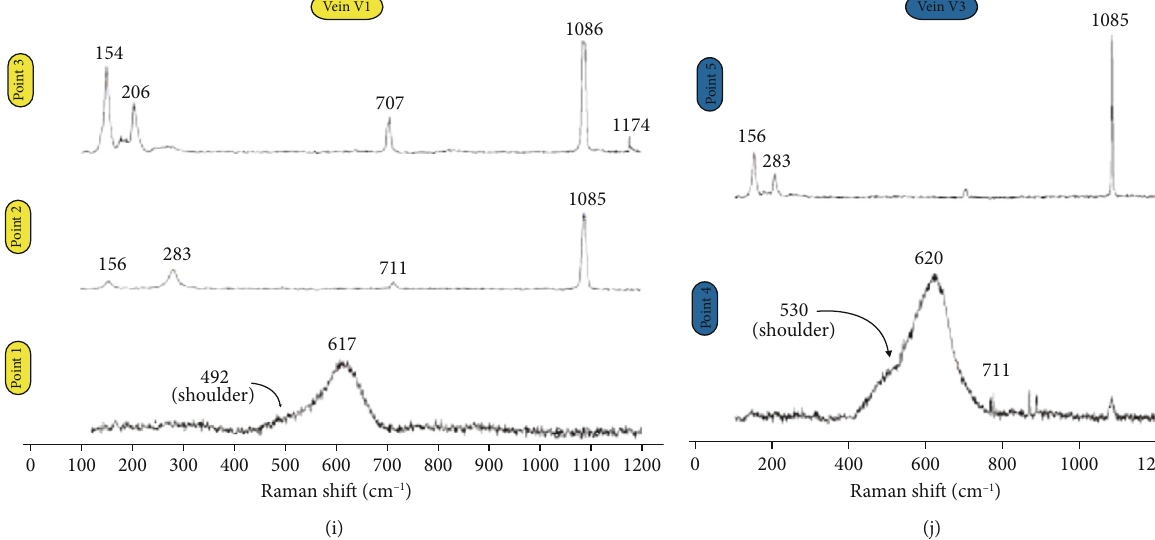
Figure 8: (a) PAM1 sample showing the bands of di ff erent colors and the three superimposed veins indicated with di ff erent colors and the acronyms V1, V2, and V. White circles indicate the analyzed point at micro-Raman. Orange circles named PAM1_1 and PAM1_2 indicate the bands used for U/Th datings. (b) XRPD pattern of vein V1. “ ? ” refers to unknown peaks. (c) SEM image showing a detail of tree-shaped structures. The white part is characterized by Mn-oxides located in a CaCO matrix, and the voids suggest that the material has been removed. 3 (d) Micrograph (crossed polars) showing detail of Mn-rich laminae in the PAM1 sample. (e) SEM image of the Mn-oxides lamina from PAM1 characterized by subrounded shape of di ff erent shades of gray. Brighter gray suggests a more important Mn-oxides concentration. (f) Chemical map of Mn-oxides lamina. (g, h) Micrograph (crossed polars) of the PAM1 sample showing bands made up of calcite and (Sr)-aragonite. The numbers refer to the points analyzed at micro-Raman. (i) Raman spectra of point 1, showing Mn-oxides band at 617cm -1 with a shoulder at 492 cm -1 , point 2 showing Calcite peaks, and point 3 showing aragonite peaks. (j) Raman spectra of point 4 showing Mn-oxides band at 620cm -1 with a shoulder at 530cm -1 and point 5 showing typical aragonite 5 : 7449 ð 5 Þ Å, and space group Pmcn ; and (ii) calcite, with the unit cell parameters a = 4 : 9713 ð 1 Þ , c = 17 : 017 ð 3 Þ Å, and